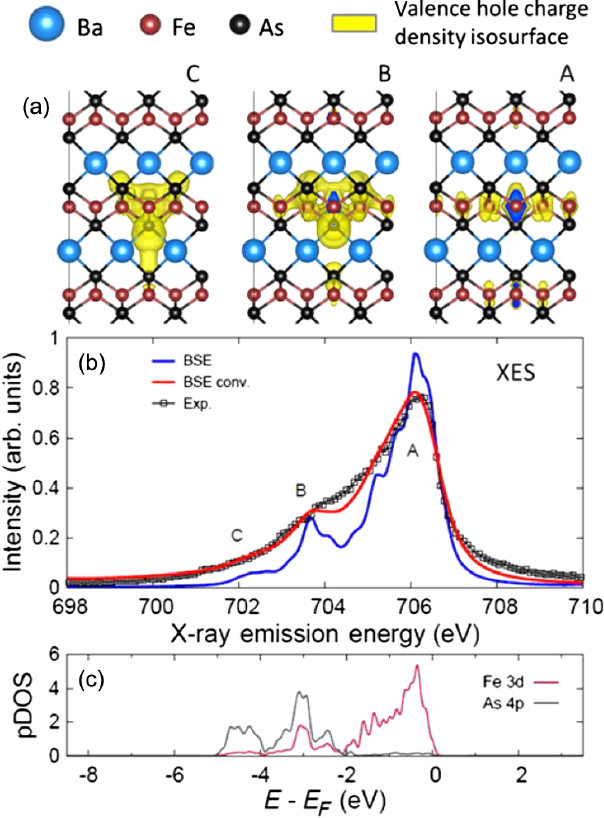
FIG. 2. X-ray emission of BaFe 2 As 2 at the Fe L 3 edge. (a) Orbital isosurface plots (yellow surfaces) of the valence-hole contribution for the BSE-calculated final state of the emission process corresponding to emission energies A – C indicated in the main figure. (b) BSE-calculated XES (blue curve) with 0.2 eV HWHM broadening compared with measurement (black sym- bols). The red curve is obtained as described in the text by convolving the BSE spectrum with a Doniach-Sunjic spectral function of asymmetry parameter 0.07 and linewidth 0.16 eV that accounts for secondary electronic excitations. (c) Ground-state projected density of states for the occupied states of selected